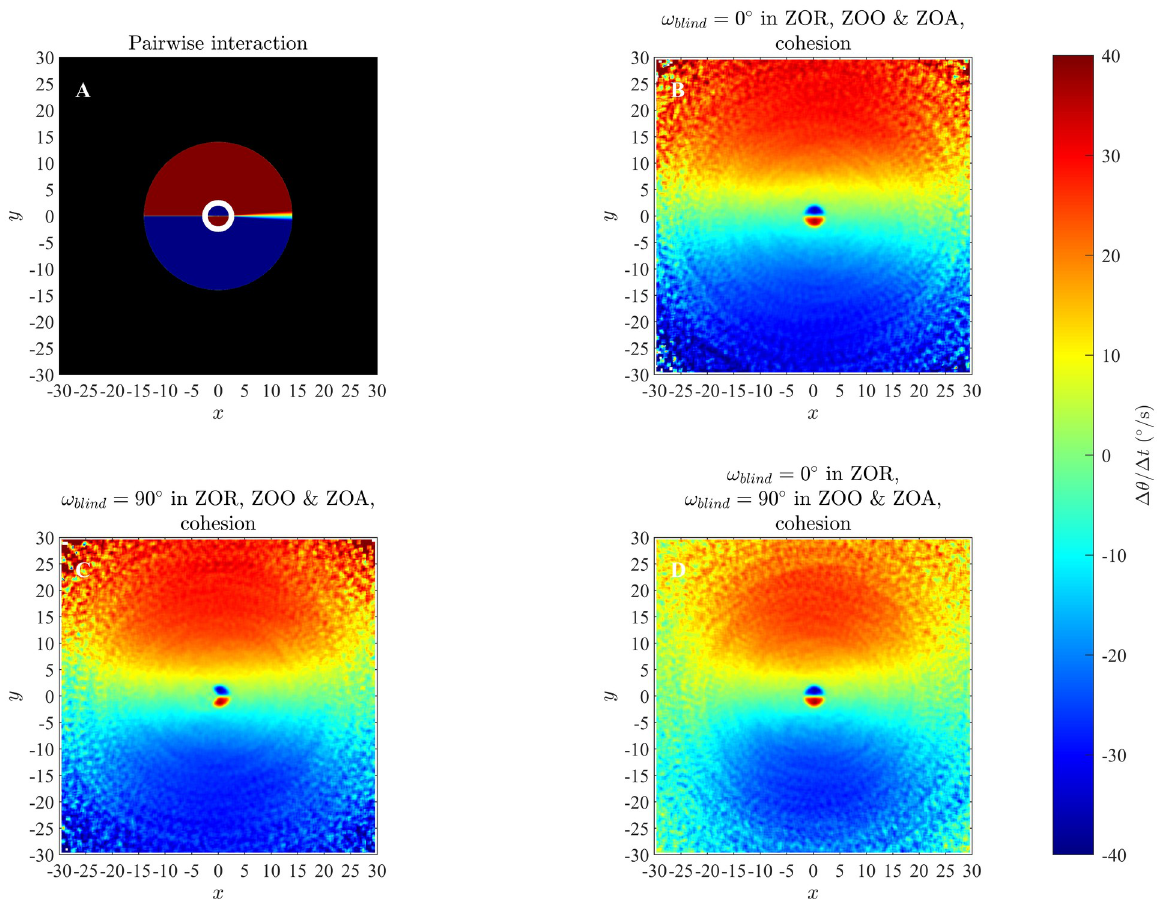
Fig 4. Panel A: analytical pairwise interactions for given parameter values, as described in S3.1 Section, where turning of the individuals is governed by equations (S3.5) and (S3.10). Panels B, C and D illustrate changes in direction of motion of individuals as a function of the relative positions of partners obtained via analysis of simulations with r with N = 25 individuals over 1000 time steps).